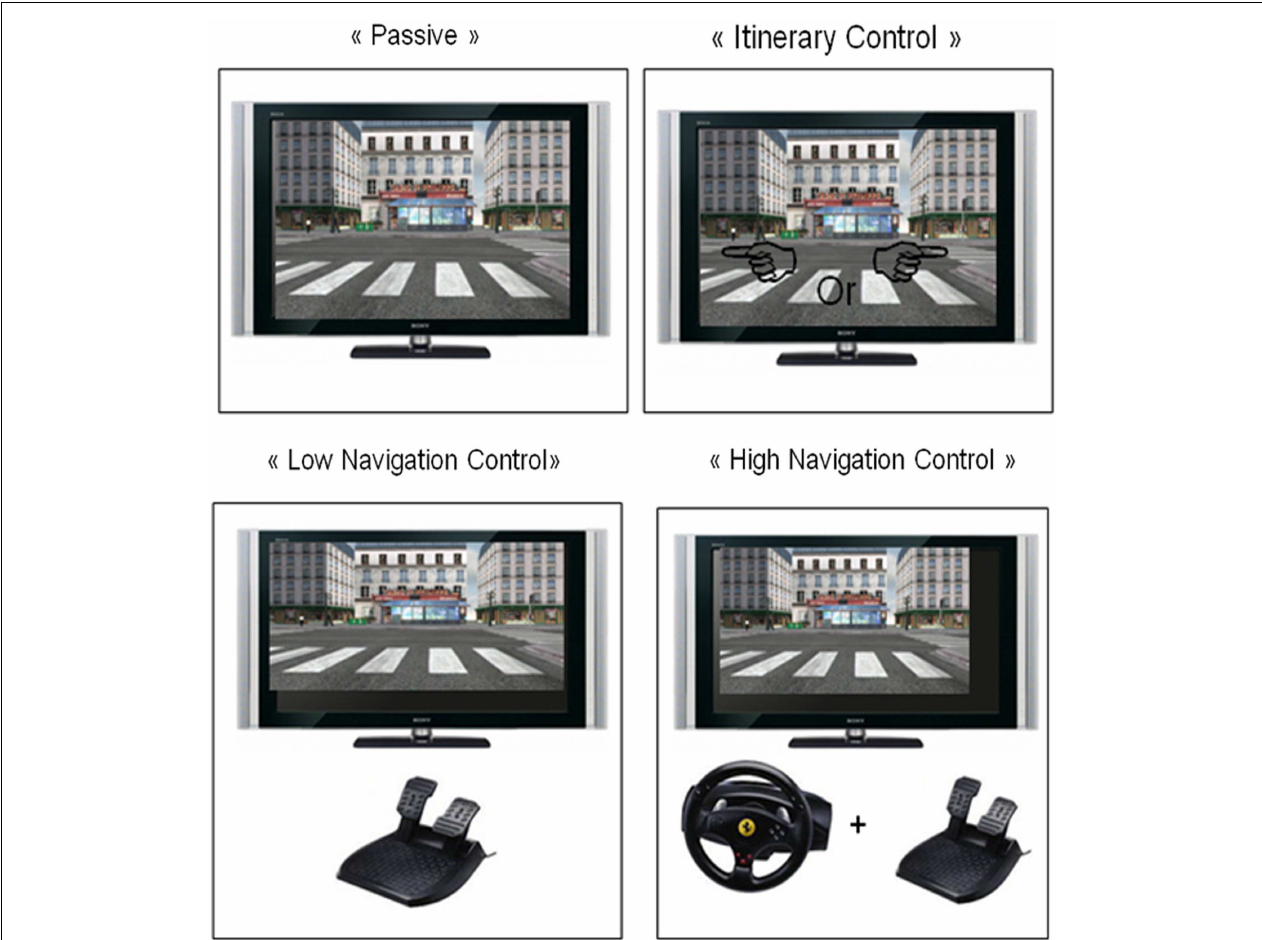
FIGURE 2 |The four experimental conditions assessed during the virtual exploration in theVR–EM test .